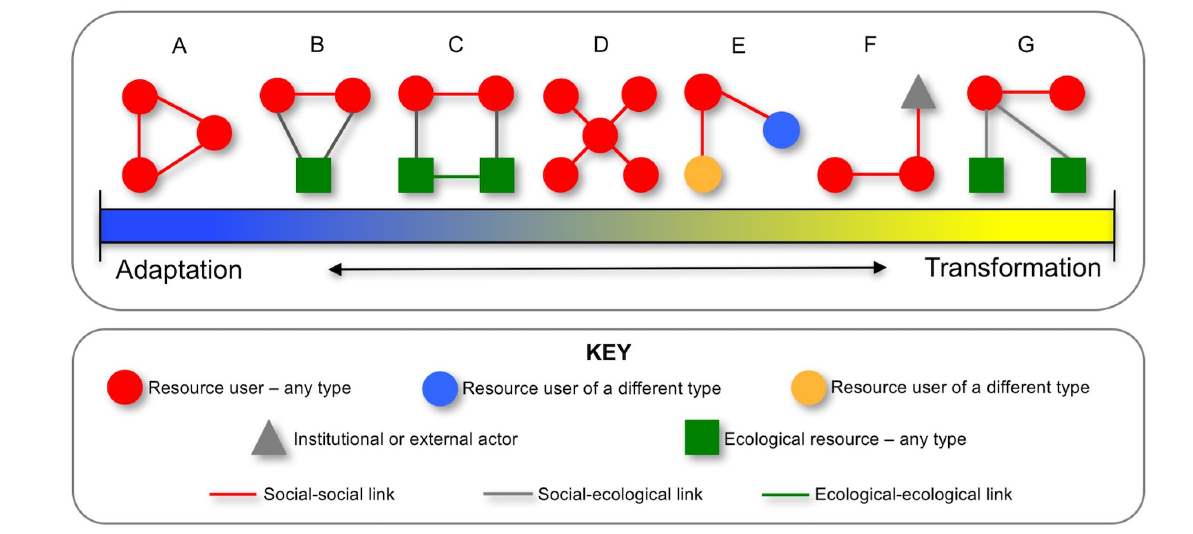
Fig. 3. A continuum of network configurations (i.e., network capacities) that set the stage for effective adaptation and transformation in social–ecological systems characterized by common-pool resources. In contrast to adaptation, which is a continual process, transformations involve multiple phases. The network configurations presented here are hypothesized to play a key role in the initial phase of transformations, yet may change throughout subsequent